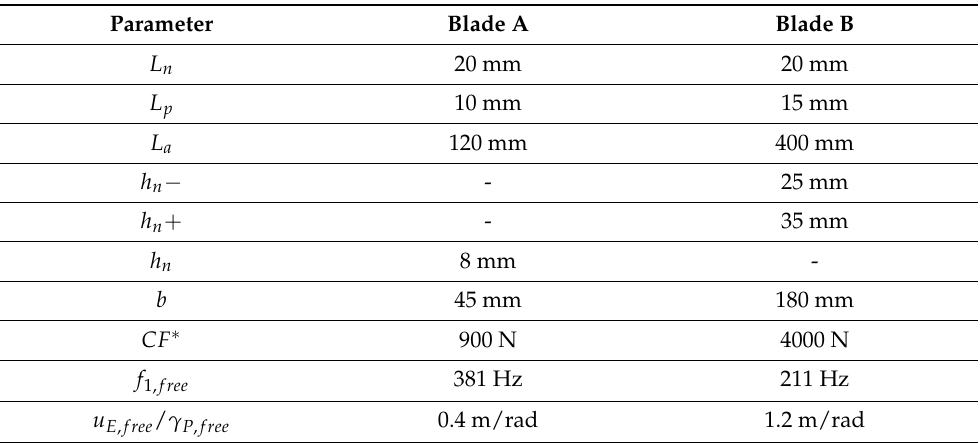
Table 2. Relevant geometrical parameters and characteristics of Blades A and B. CF ∗ is the nominal centrifugal force on the damper (rounded to the next hundred) based on information on damper mass, disk radius, and rotational speed (not